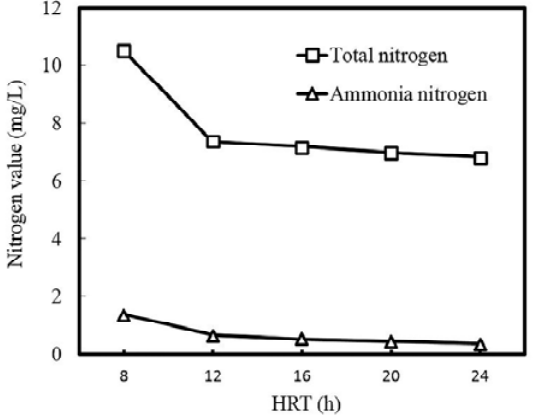
Figure 5. Variations in total nitrogen and ammonia nitrogen of the effluent at different HRTs.